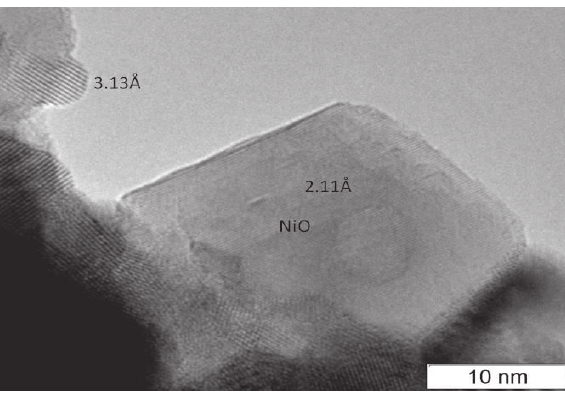
Figure 10b: reference UV-Vis spectrum of NiO oxide calcined at 900 o